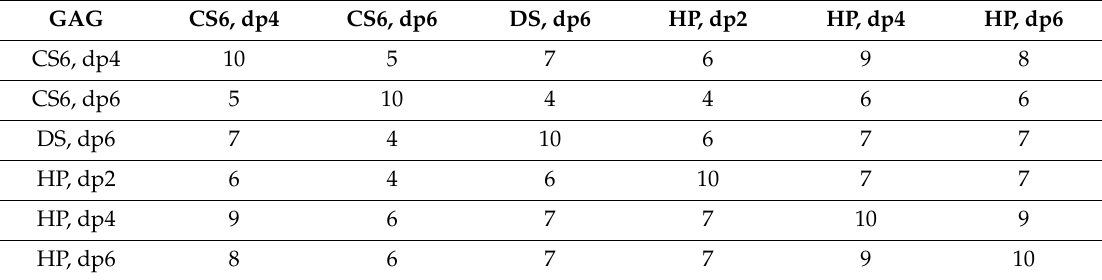
Table 4. Similarity of GAG binding poses for the NTR domain as of the number of common amino acid residues identified in the top 10 for binding according to MM-GBSA calculations per